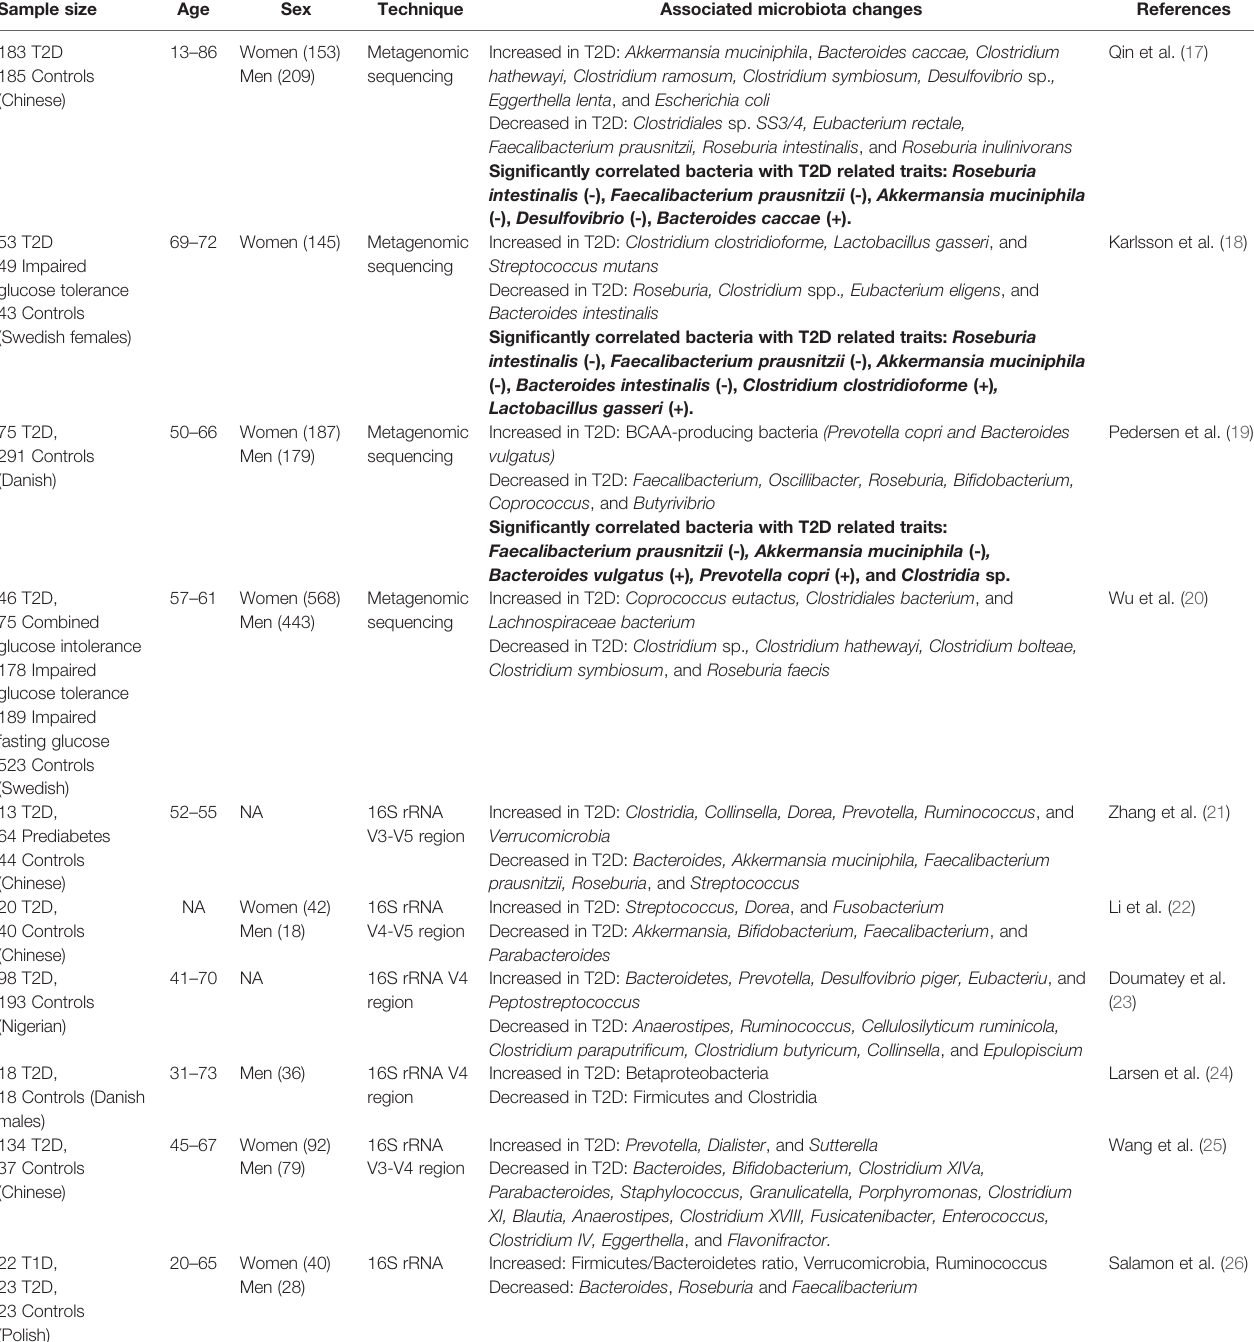
TABLE 1 | T2D-related gut microbiota found in human studies. Sample